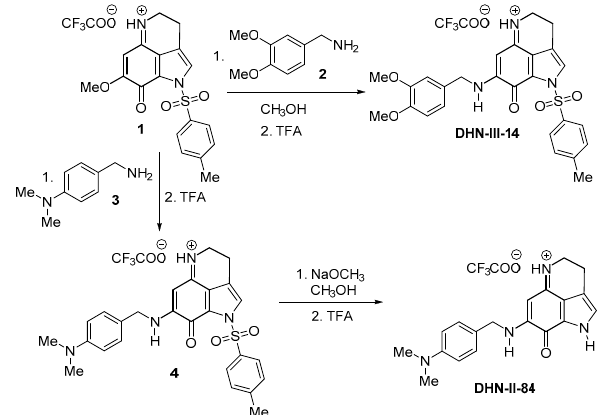
Figure 10. Synthesis of test compounds DHN-II-84 and DHN-III-14. Figure 9. Synthesis of test compounds DHN-II-84 and